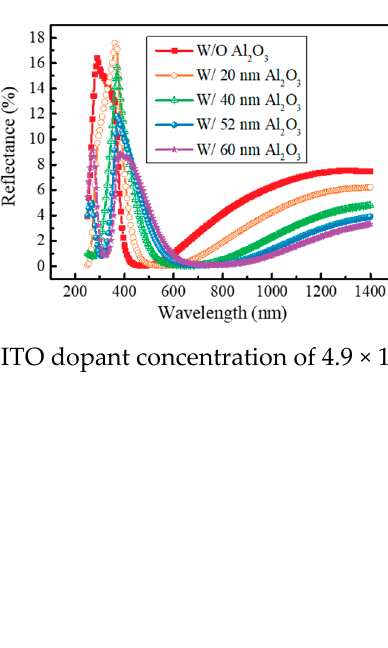
Figure 3. Current density performed with the Al 2 O 3 /ITO/Si structure via OPAL 2 simulation. J R , J A , and J G are plotted against Al 2 O 3 layer thickness at different ITO dopant concentrations. ITO dopant concentration: ( a ) 2.0 × 10 20 , ( b ) 4.9 × 10 20 , and ( c ) 6.1 × 10 20 / cm 3 .